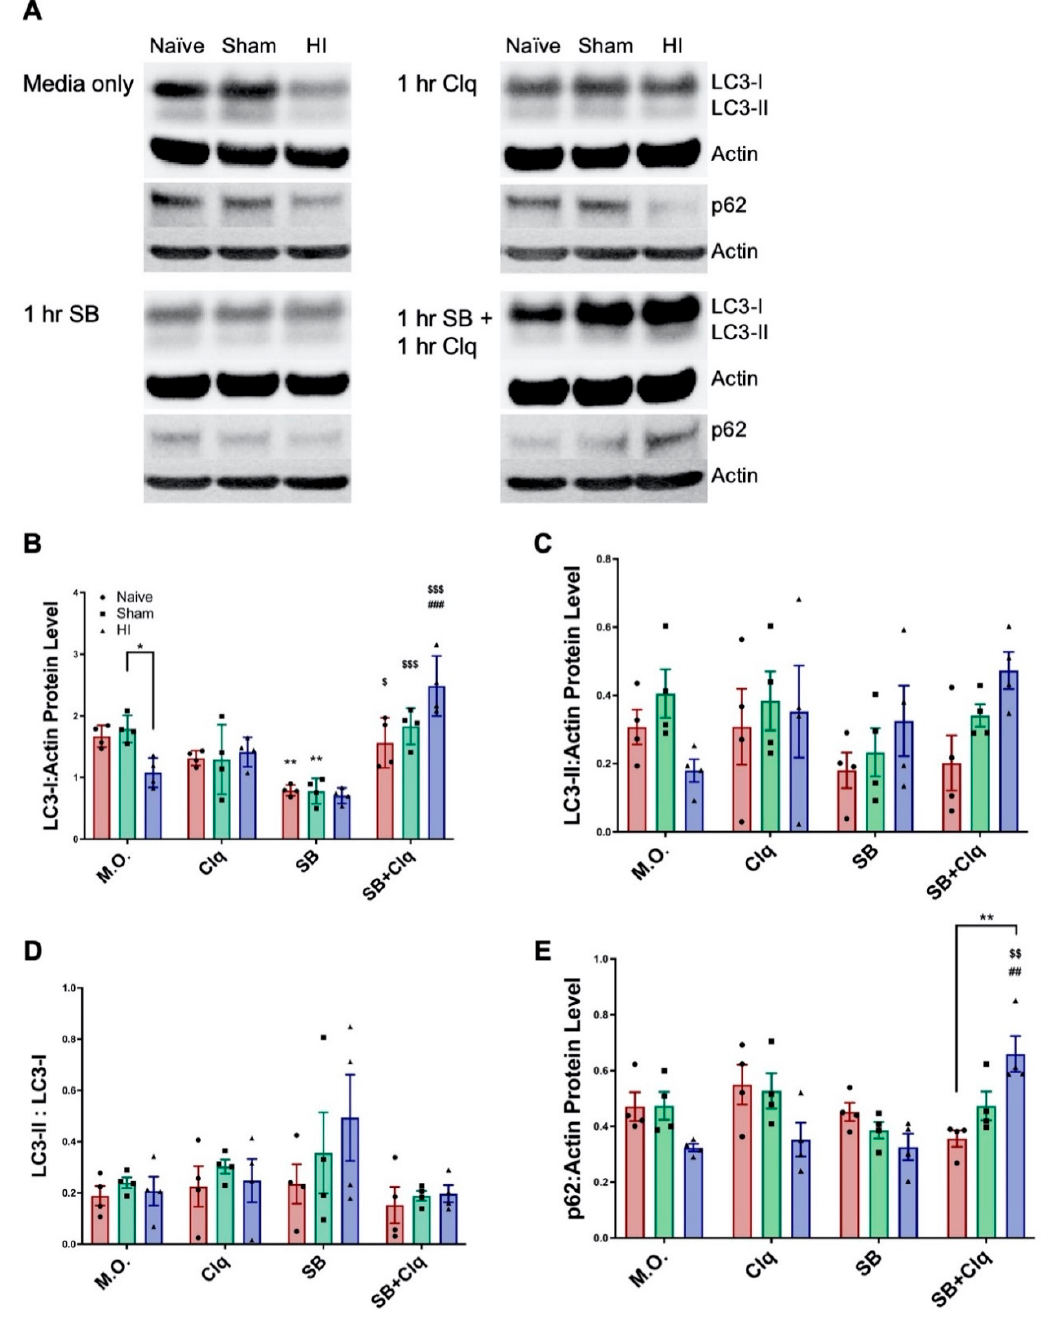
Figure 2. SB505124 induced autophagic flux in the injured hemisphere after HI Injury. Three days after HI, 1000 μ m thick coronal slices were incubated with SB505124 (SB) or SB505124 + chloroquine (SB+Clq) in DMEM w/20% horse serum (Media Only control, M.O.) for 2 h total in 37 °C, 5% CO 2 to assess the effect of SB505124 on active autophagy. The injured hemisphere was collected and protein extracted for Western blot. ( A ) Representative blot for LC3, p62, and β -Actin (loading control) from the injured hemisphere. ( B ) Quantitative analysis of band optical densities for LC3-I, ( C ) LC3-II, ( D ) ratio of LC3-II/LC3-I band densities, and ( E ) band optical densities for p62. n = 4–5 per group. Data are presented as means ± SEM; * p < 0.05, ** p < 0.001 when denoted by bracket; ** p < 0.001 for M.O. vs. SB treated slices; ## p < 0.001, ### p < 0.0001 for Clq treated vs. SB+Clq treated slices; $ p < 0.05, $$ p < 0.001, $$$ p < 0.0001 for SB treated vs. SB+Clq treated slices by two-way ANOVA followed by Tukey’s multiple comparison test.